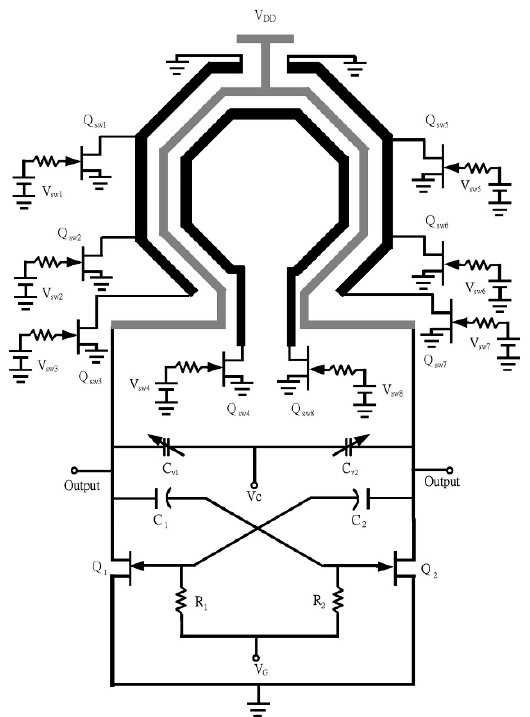
Figure 4. Complete schematic of the switched inductor VCO with two transformers.